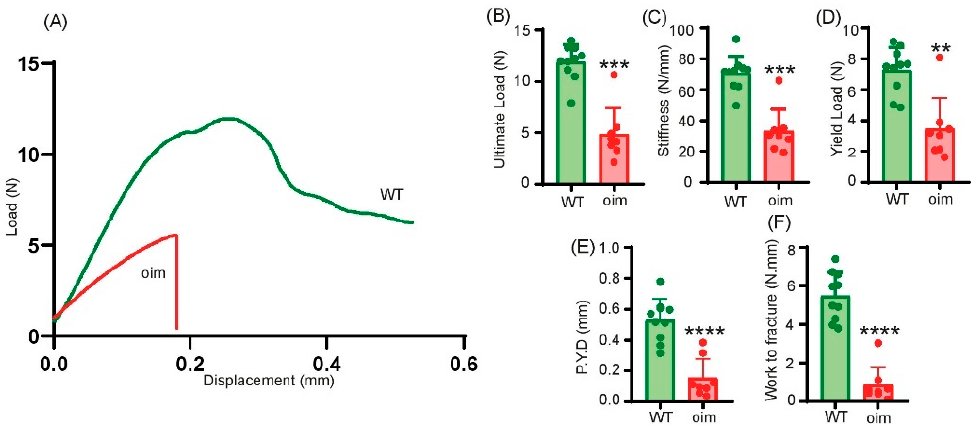
Figure 3. Biomechanical parameters of bone in 5-week-old WT and oim mice. ( A ) Example of load–deformation curves obtained in WT mice (green line) and oim (red line). ( B ) Ultimate load (N), ( C ) stiffness (N/mm), ( D ) yield load (N), ( E ) post-yield displacement (P.Y.D, mm) and ( F ) work to fracture (N.mm) computed from load–displacement curves. n = 10 and n = 8 for WT mice and oim, respectively. ** p < 0.01, *** p < 0.001, **** p <